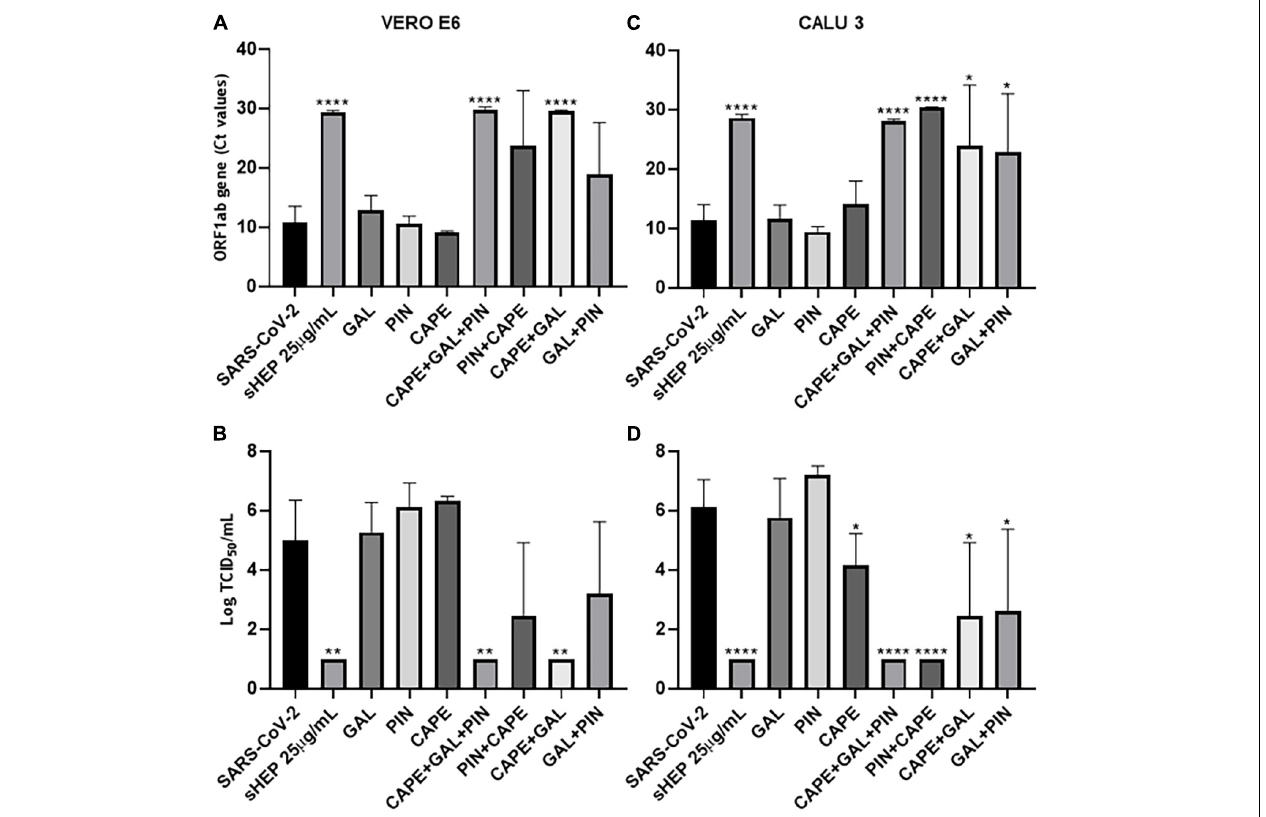
FIGURE 5 | Ability of the three main components of sHEP, the Caffeic Acid Phenethyl Ester (CAPE), the Galangin (GAL), and the Pinocembrin (PIN), to reduce viral replication on infected VERO E6 and CALU 3 cells. The three components of sHEP where added to the culture medium of VERO E6 and CALU 3 after virus inoculation, at the same concentration they were contained in sHEP. The sHEP components were tested singly (CAPE or GAL or PIN), or in combination two by two (CAPE + GAL; GAL + PIN; CAPE + PIN), or all together (CAPE + GAL + PIN), as indicated in the graphs; as a reference, the values measured in the presence of sHEP (sHEP 25 µ g/mL) or the SARS-CoV-2 INMI1 alone (SARS-CoV-2) were also shown. After 48 h of culture, viral yield and virus titration in SNs were analyzed. Panels (A,C) : viral yield (expressed as Ct values of ORF1ab gene transcripts) observed in SNs of VERO E6 and CALU3, respectively. Panels (B,D) : virus titration (expressed as Tissue Culture Infectious Dose TCID 50 /mL) measured in SNs of VERO E6 and CALU3, respectively. Data represent the mean ( ± SD) of three independent experiments. The asterisks indicate statistically significant differences determined by Student’s t -test (**** p < 0.0001, ** p < 0.01; * p < 0.05; no asterisk, p ≥ 0.05) between infected cells and those infected and cultured in presence of sHEP or components used singly or in